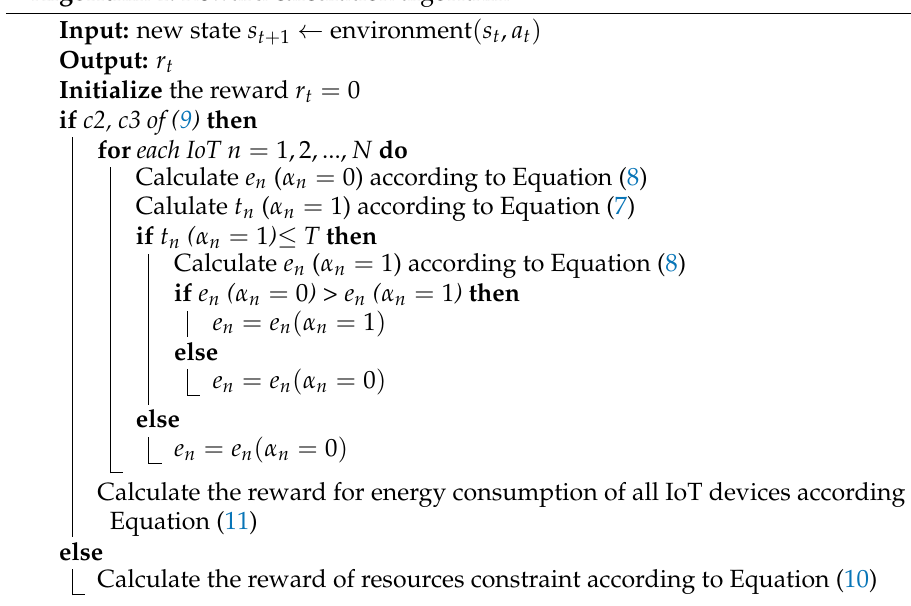
Algorithm 1: Reward calculation